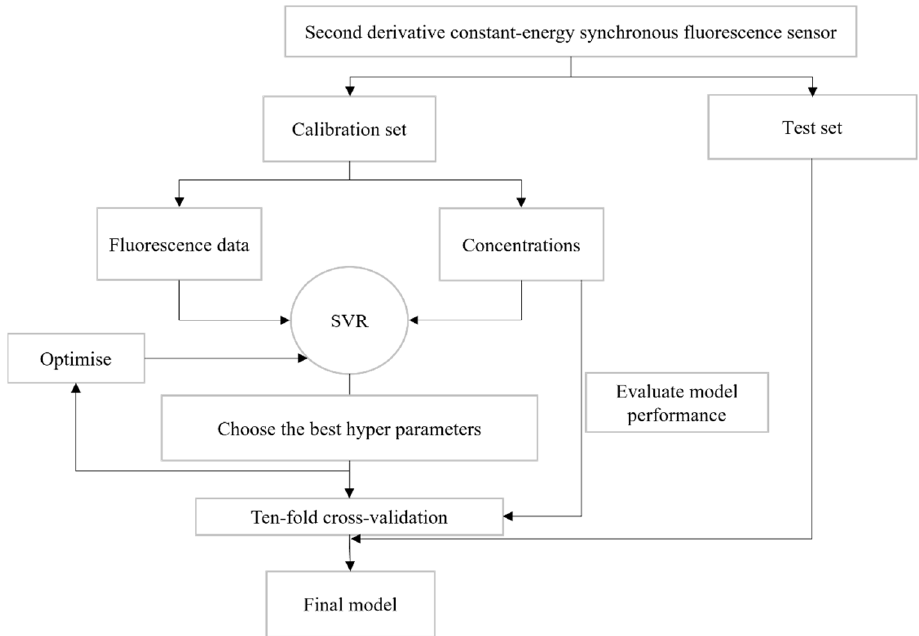
Figure 4. The process of our model building.